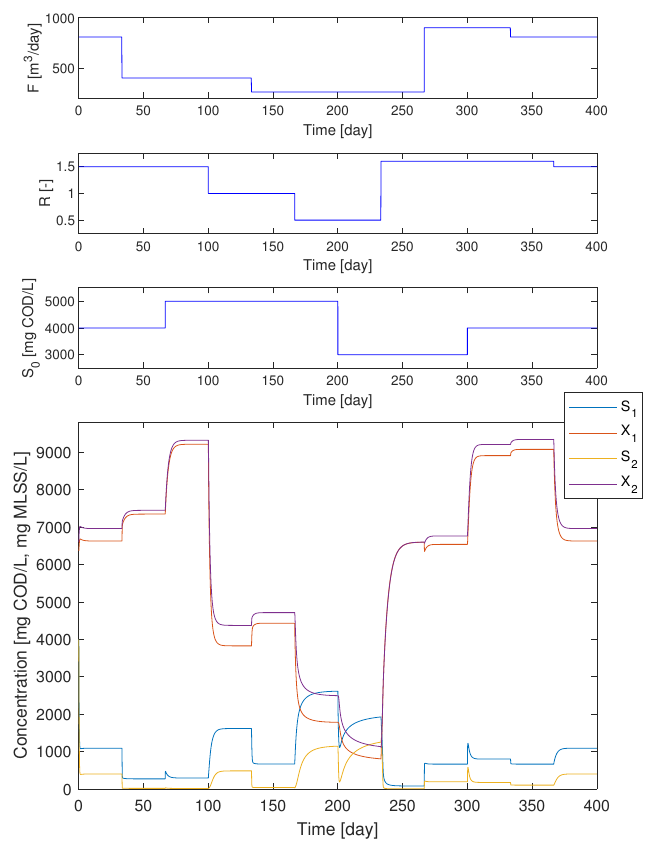
Figure 4. The input and state variables over time.According to Table 2, F ≤ F max in every pe- riod of time. Equations (13)–(16) were discretized and solved iteratively with a sampling time of dt = 0.01 days to acquire the model outputs. The initial state vector was x 0 = [ S 1,0 X 1,0 S 2,0 X 2,0 ] = [ 4000 6400 4000 6600 ]